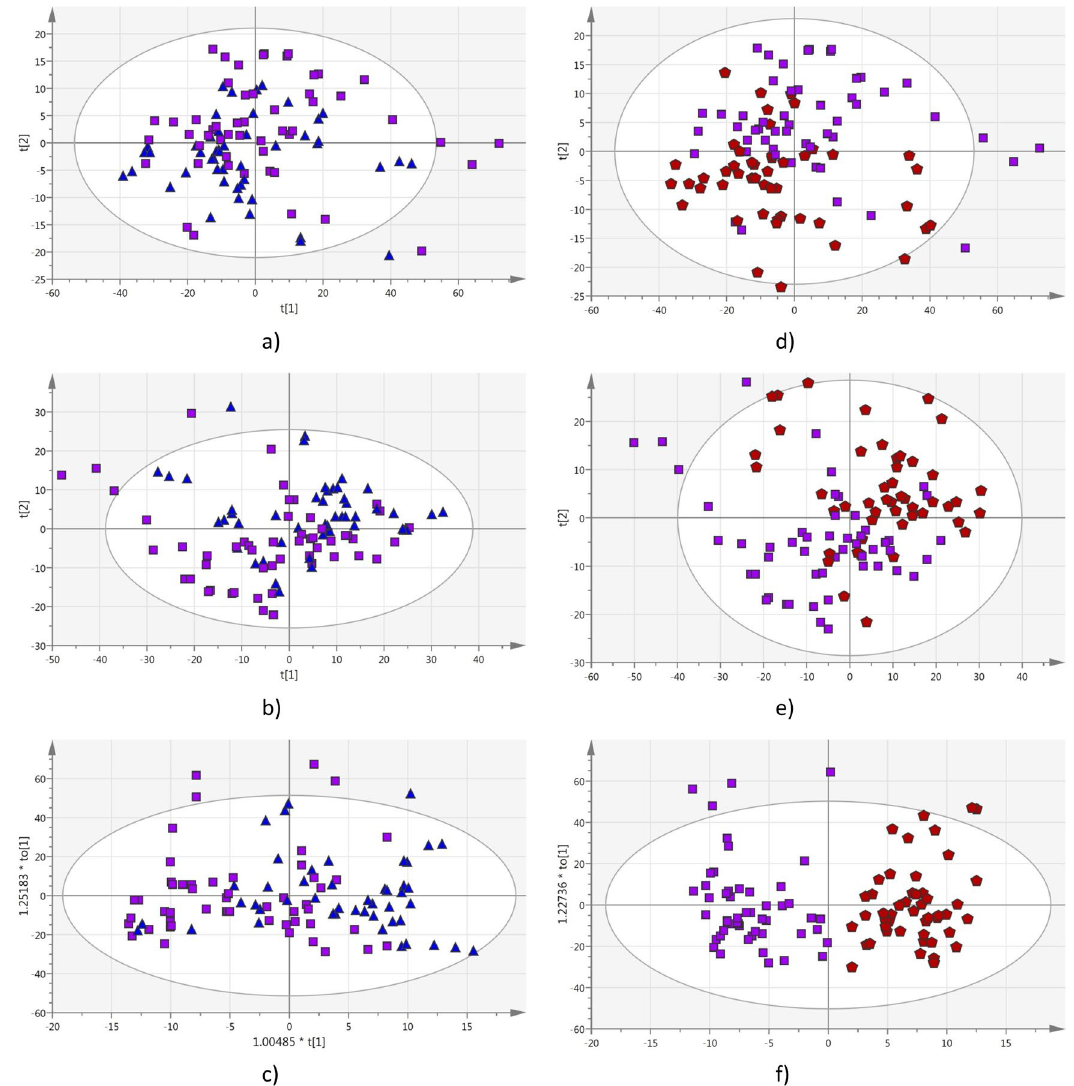
Figure 2. ( a ) PCA Scores plot; ( b ) PLS-DA Scores plot; ( c ) OPLS-DA Scores plot; analysis comparing UV–Vis spectra of pomegranate juices (squares) to those of 10% (triangles) mixtures. ( d ) PCA Scores plot; ( e ) PLS-DA Scores plot; ( f ) OPLS-DA Scores plot; analysis comparing UV–Vis spectra of pomegranate juices (squares) to those of 20% (pentagons)